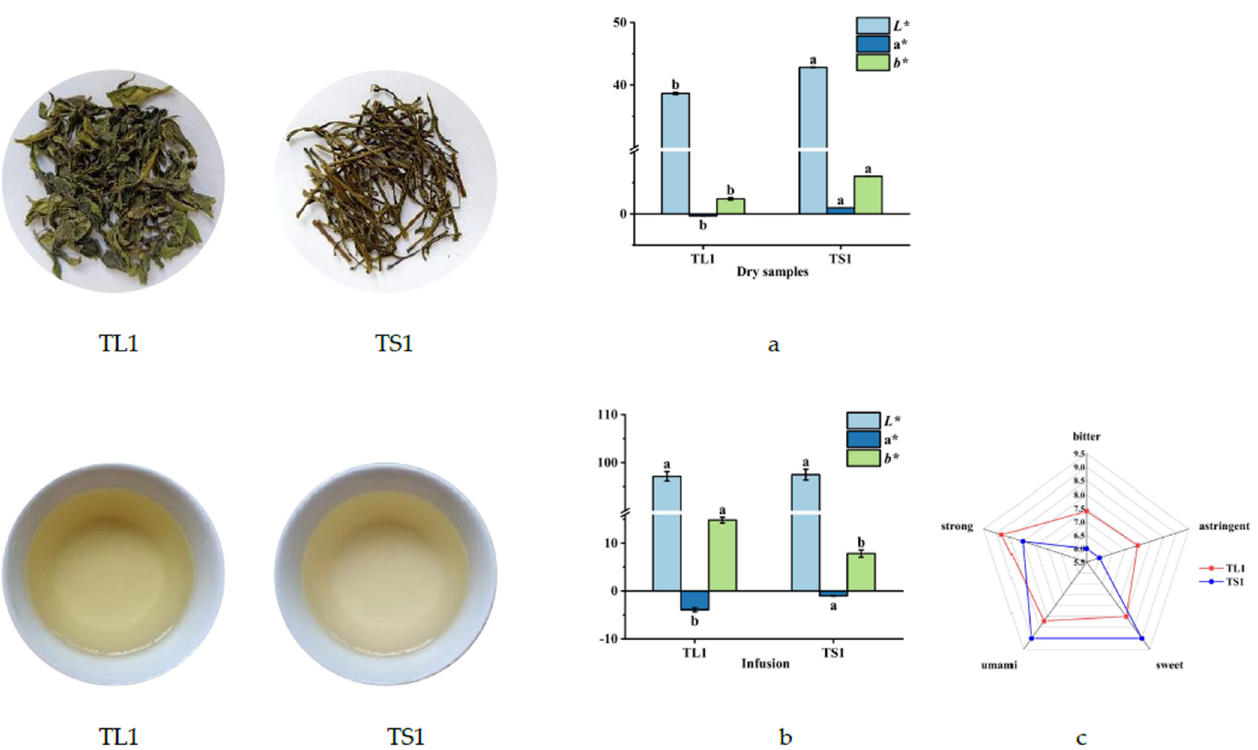
Figure 2. Difference in the colors of dry leaf and stem samples and infusions and sensory evaluation of stems and tea leaf infusions. ( a ) Difference in the colors of dry leaf and stem; ( b ) Difference in the colors of stems and tea leaf infusions; ( c ) Sensory evaluation of stems and tea leaf infusions. Different superscript letters denote significant differences ( p < 0.05).